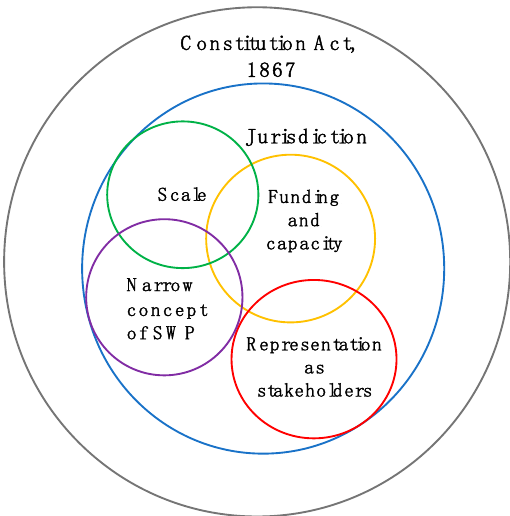
Figure 2. Thematic source water protection challenges faced by Indigenous communities, as identified through interviews and a focus group with Indigenous community members and practitioners from industry, academia, NGOs, and government. Themes that interact with one another overlap. All thematic issues are framed by the 1867 Canadian Constitution Act, which provides the federal government with jurisdiction over lands reserved for Indigenous peoples.